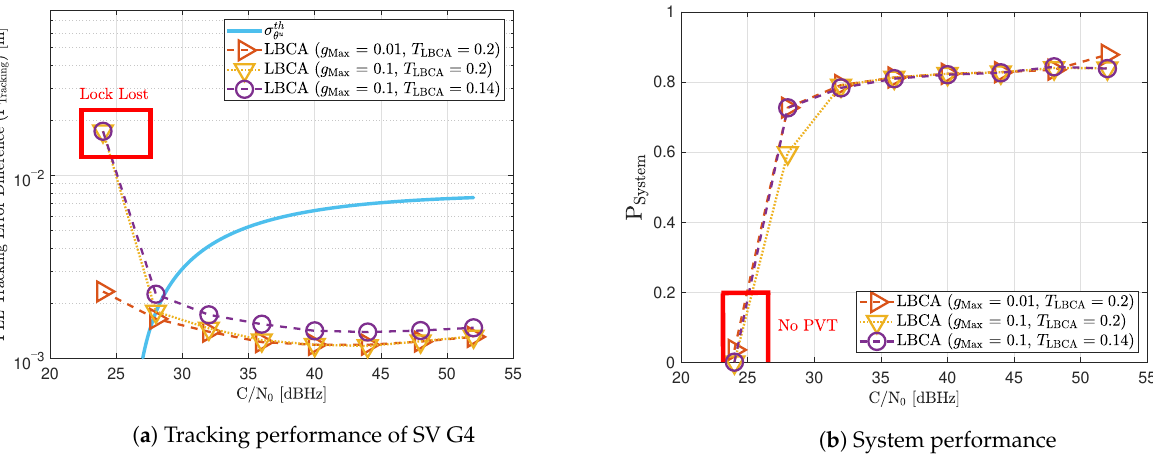
Figure 23. Static performance of loop-bandwidth control algorithm (LBCA) PLL at different C / N 0 levels. As expected, a lower g Max leads to a smaller oscillation range of the estimated loop bandwidth (see Figure 24). Also, a decrease in T LBCA increases the average loop band- width estimate.